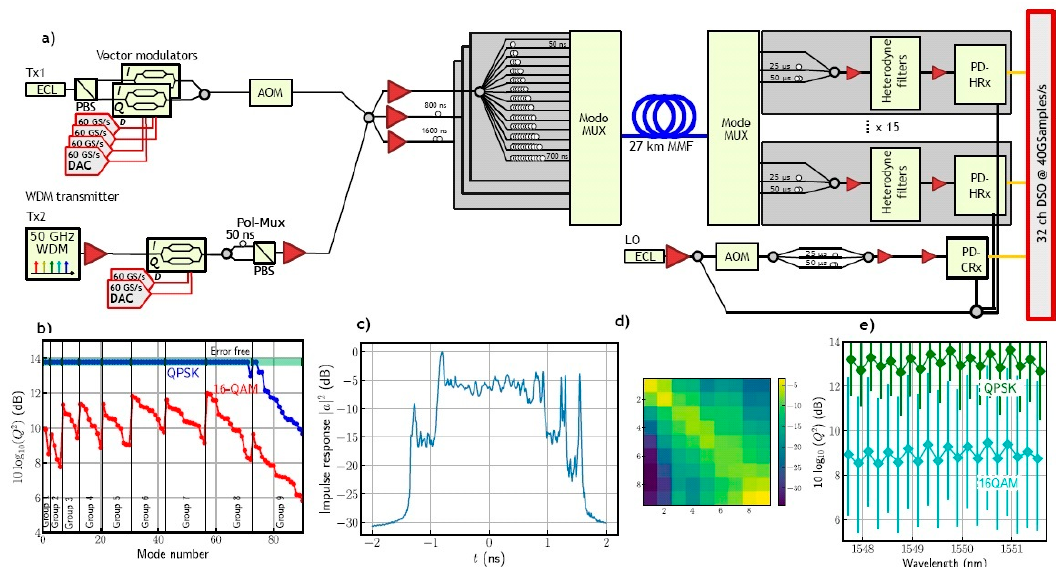
Figure 33. ( a ) Setup of a 90 × 90 MIMO-based transmission; ( b ) Q-factors for QPSK and 16QAM; ( c ) intensity-averaged impulse response attained; ( d ) intensity transfer matrix; ( e ) average Q-factor for QPSK and 16QAM [47].